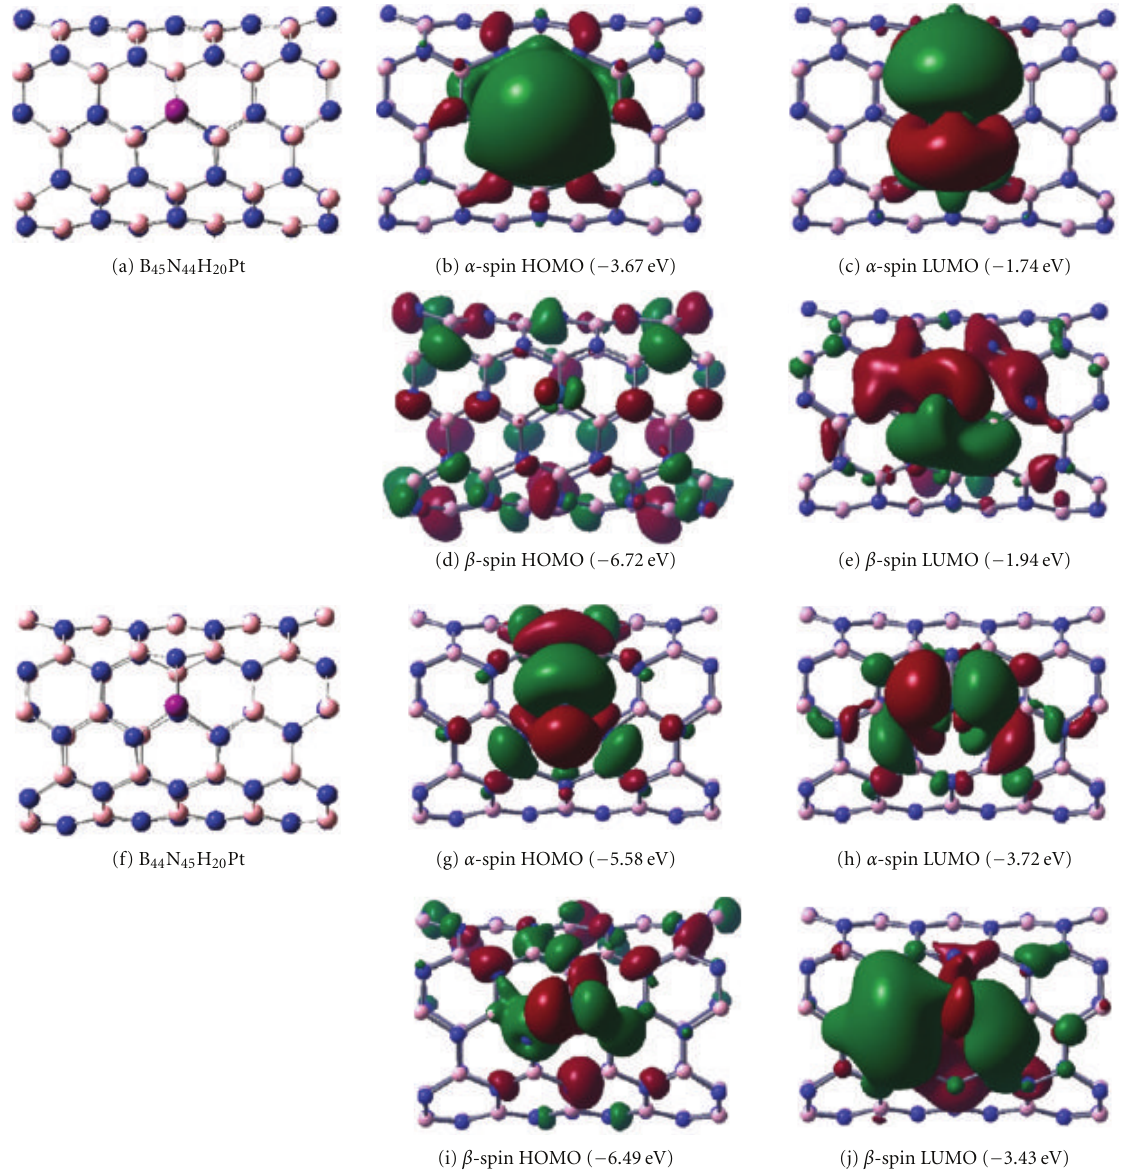
Figure 18: Optimized geometries of Pt-doped BNNT resulting from N-substitution (i.e., B 45 N 44 H 20 Pt) and B-substitution (i.e., B 44 N 45 H 20 Pt) and their relevant FMOs. Orbital energies are in parentheses [200]. Legend: pink = boron, navy blue = nitrogen, dark pink =